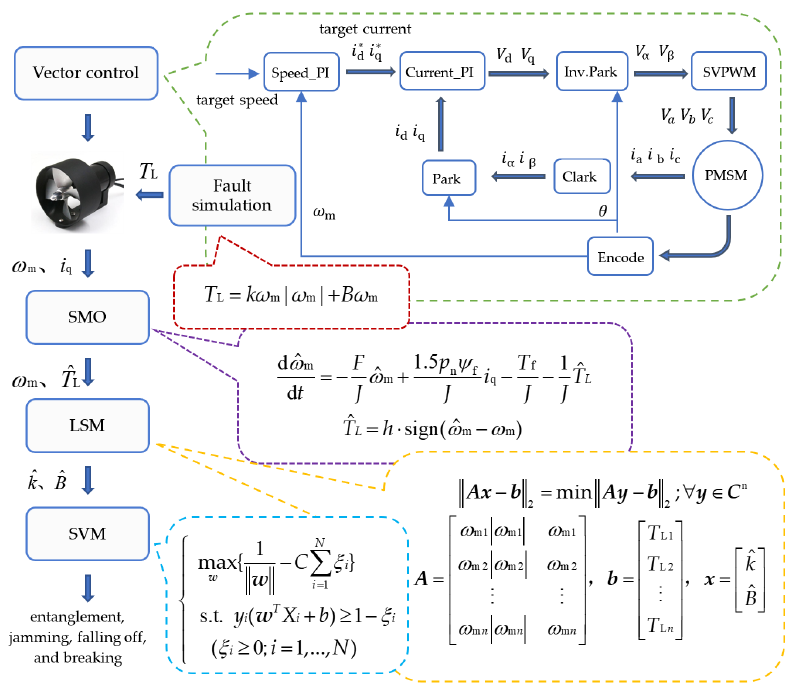
Figure 2. Thruster fault diagnosis block